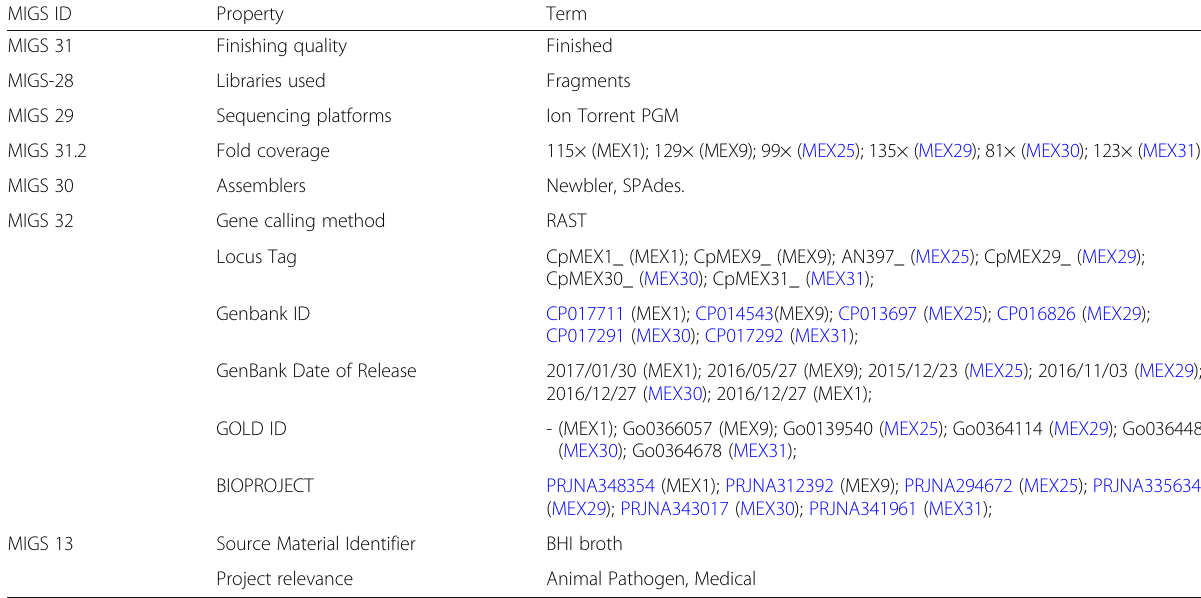
Table 2 Project